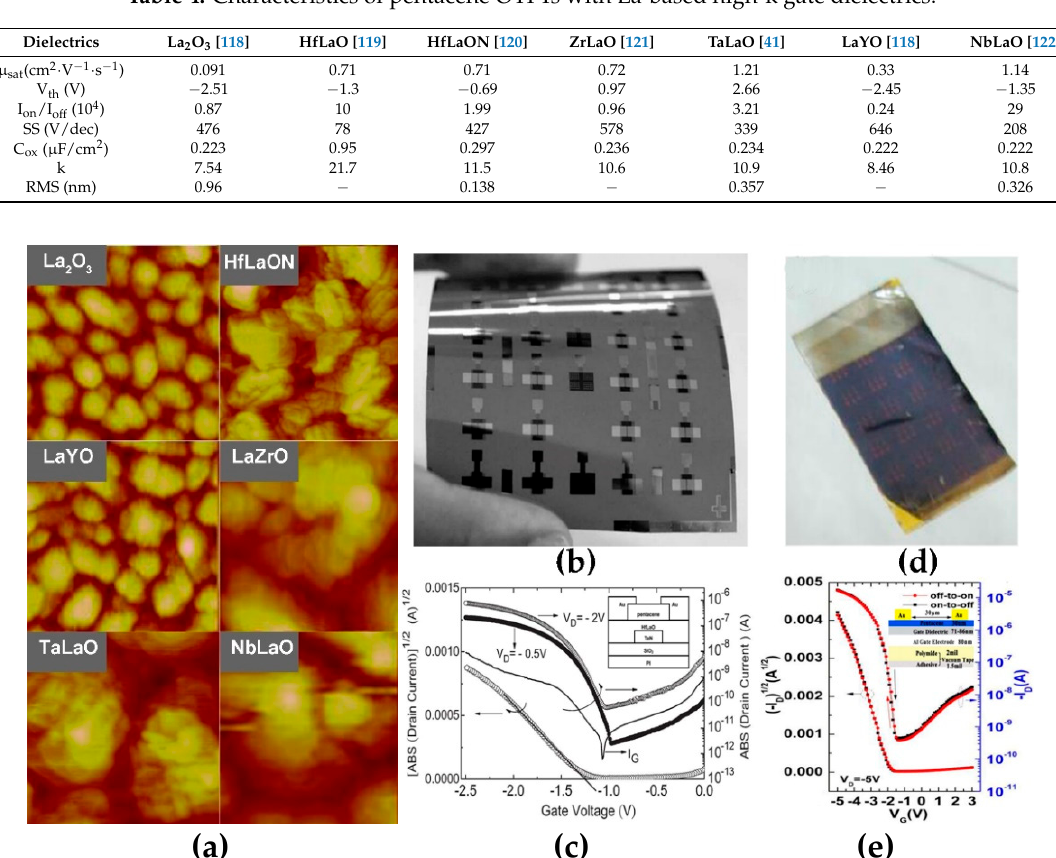
Figure 15. Pentacene OTFT: ( a ) surface morphology (1 µ m × 1 µ m) of pentacene films grown on different La-based high-k dielectrics [118], ( b ) devices made on PI substrate, ( c ) transfer characteristics for HfLaO gate dielectric on PI substrate [123], ( d ) devices made on vacuum tape, and ( e ) transfer characteristics for NbLaO gate dielectric on vacuum tape [124]. Table 4. Characteristics of pentacene OTFTs with La-based high-k gate dielectrics. Dielectrics